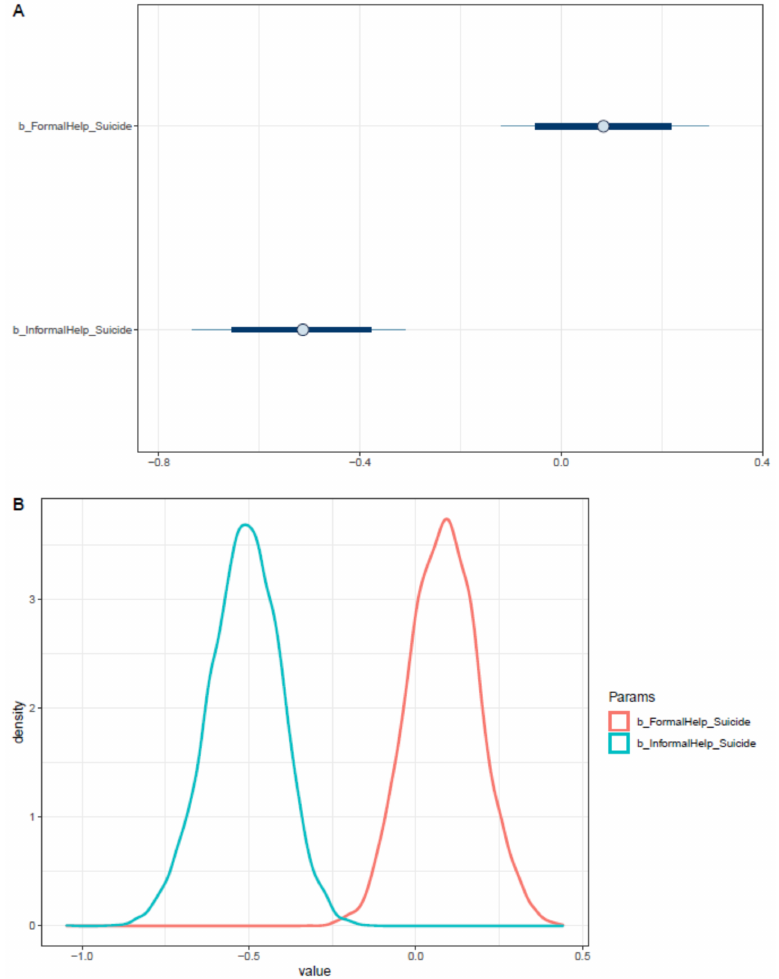
Figure 18. Distributions of Model 4 (cid:48) s posterior coefficients. ( A )–Interval plot; ( B )–Density plot.